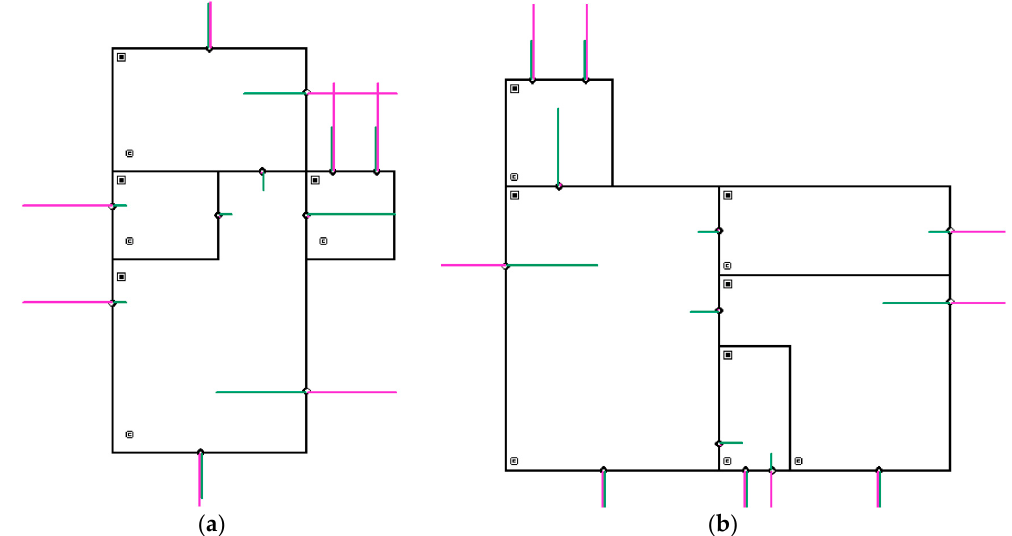
Figure 4. CONTAM SketchPad representation of pressure and flow in ( a ) dwelling “A” and ( b ) dwelling “B”. The airflow rates are denoted as green lines and pressure differences as pink lines.